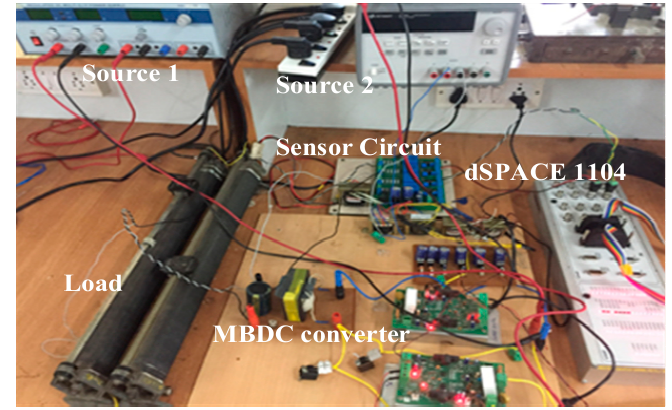
Figure 11. Prototype of the proposed MBDC converter.